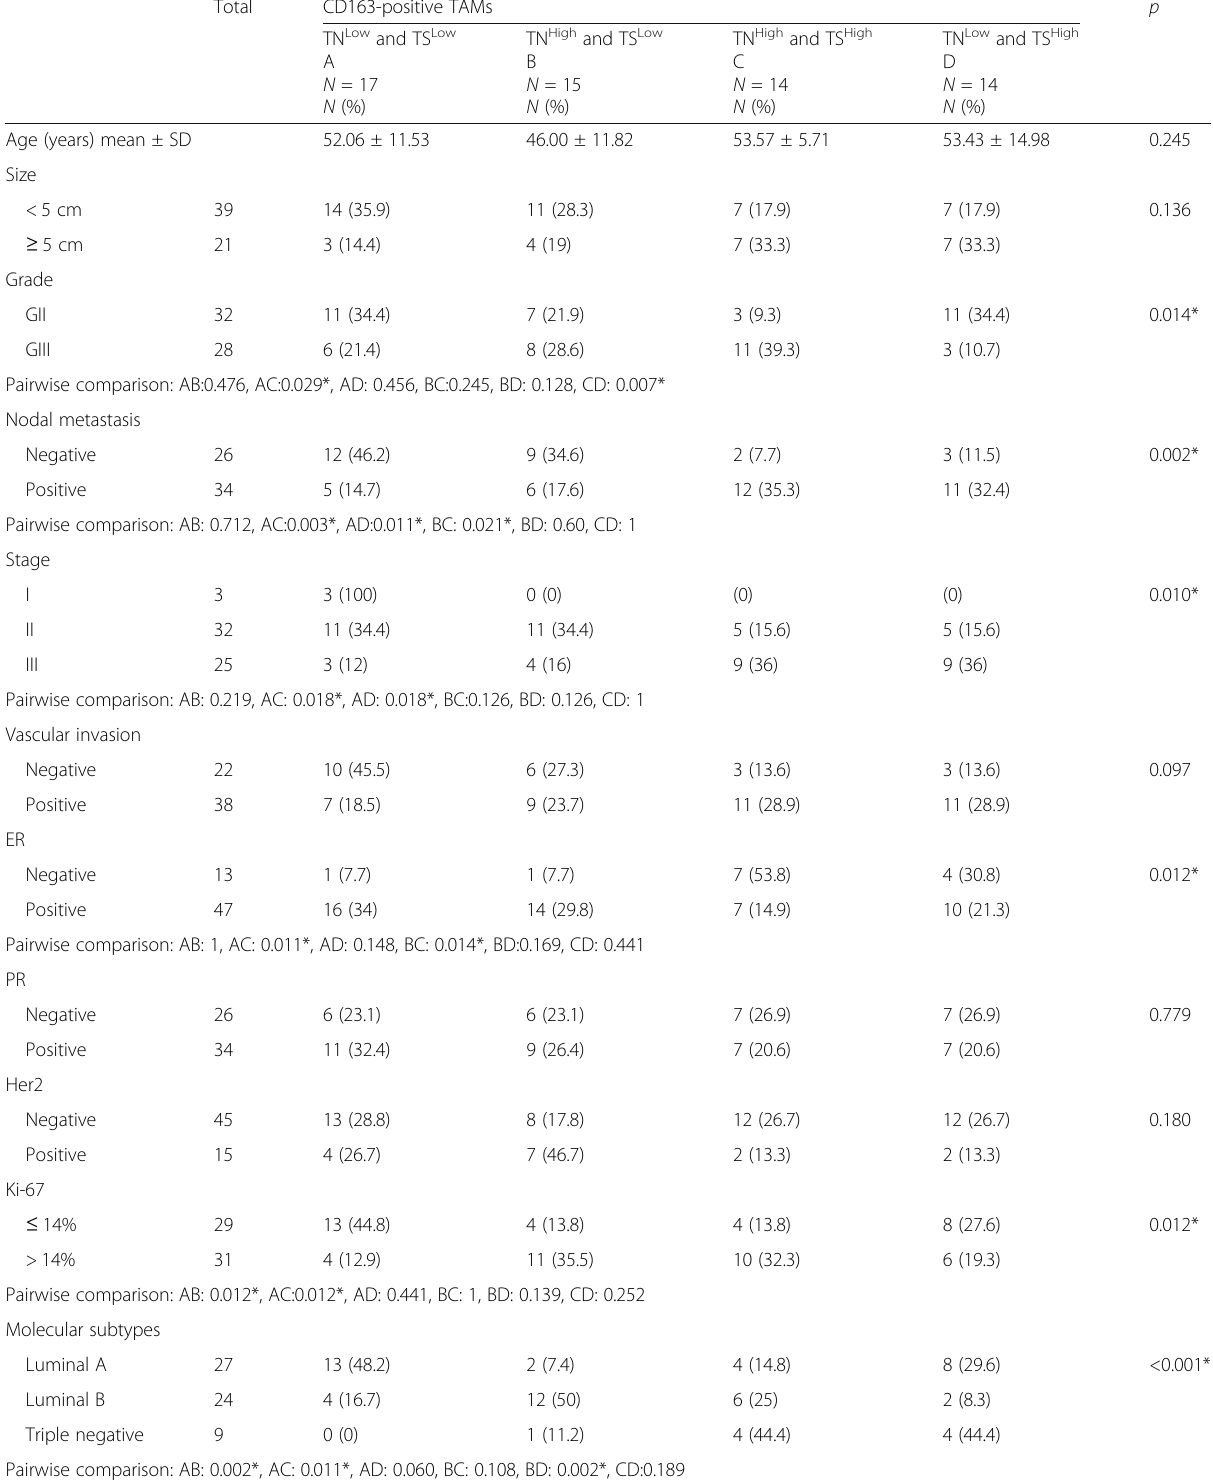
Table 7 Relation between combined densities of CD163 expression in both tumor nest and stroma and clinicopathologic